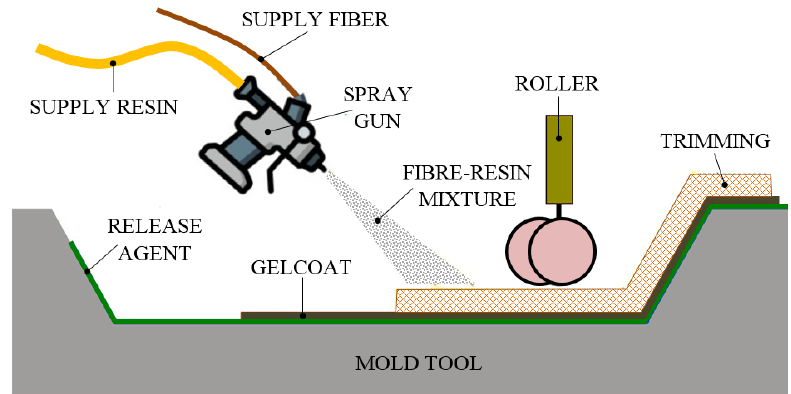
Figure 11. Schematic diagram of the spray lay ‐ up manufacturing method.